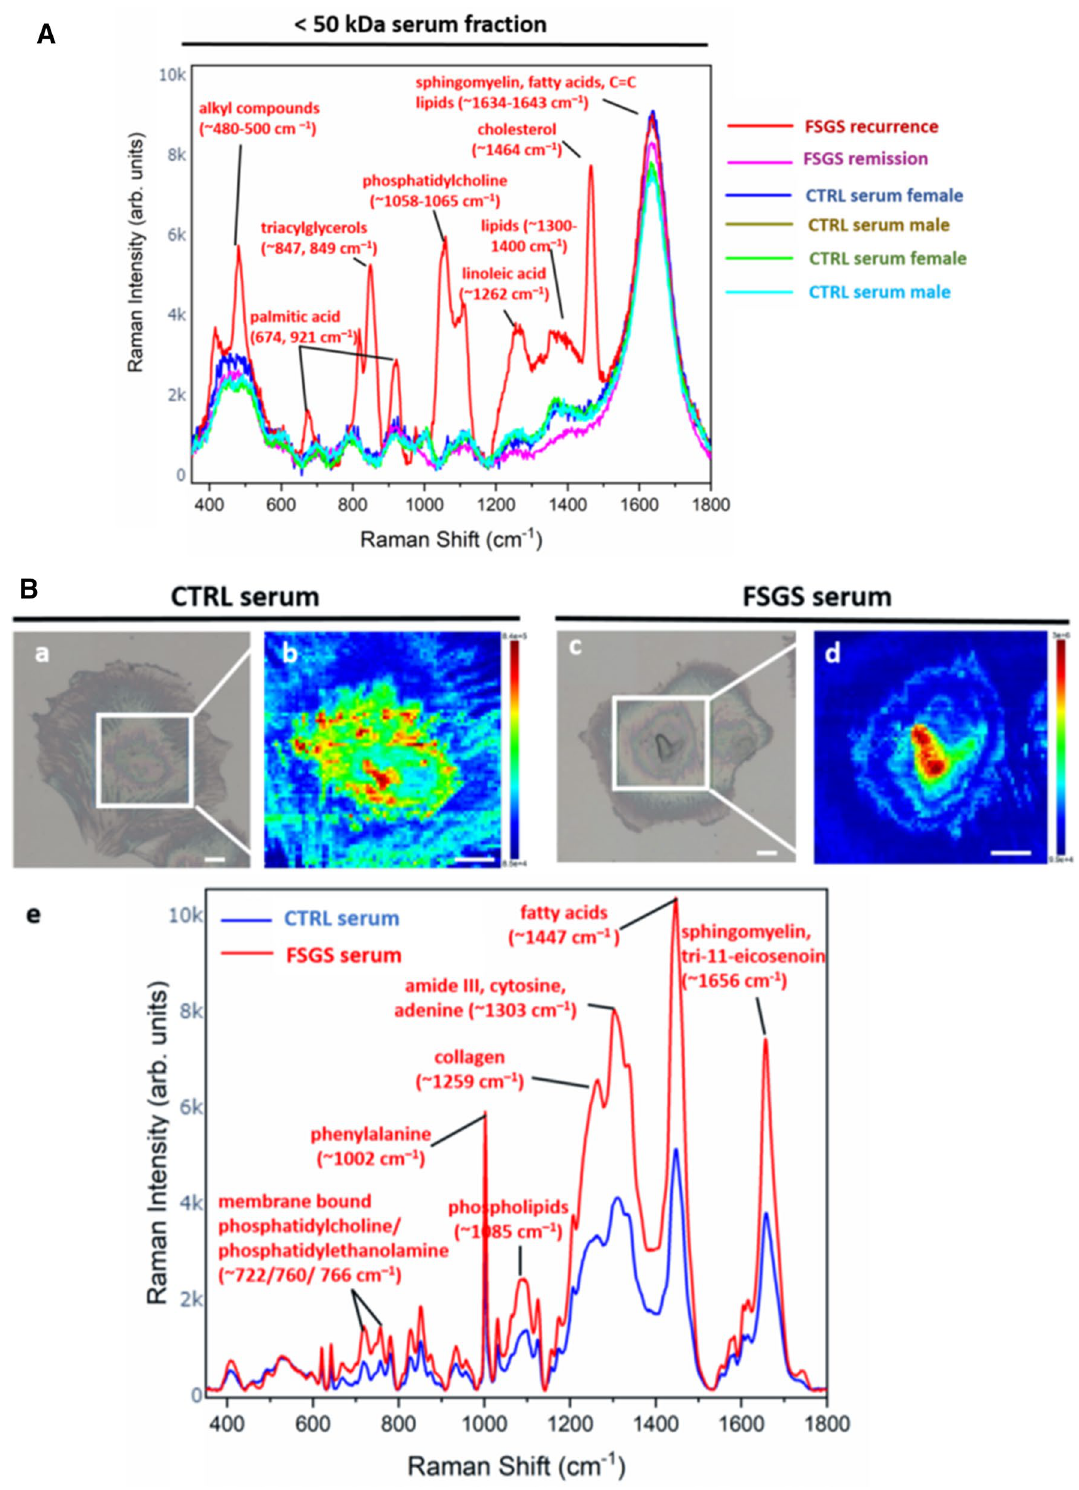
Figure 3. Raman spectroscopy reveals molecular fingerprint of FSGS serum and changes in podocyte metabolome induced by FSGS serum. ( A ) Mean Raman spectra of < 50 kDa serum fractions of FSGS at the time of disease recurrence (red), at the time of remission (purple) as well as of < 50 kDa serum fractions of four healthy control person (dark blue, green, brown and light blue). Different Raman signal corresponding mostly to lipoproteins were detected at the time of FSGS recurrence. Raman signals at the time of FSGS remission however resembled Raman signals of the CTRL serum fraction. Assignments of the Raman peaks according to the literature are given. ( B ) Representative bright field illumination (a,c) and heat map of Raman signal intensity (b,d) of cultured human podocytes treated with CTRL serum (a,b) and FSGS serum (c,d). Scale bar 10 µm. (e) Mean Raman spectra of three podocytes treated with FSGS serum (red line) and three podocytes treated with CTRL serum (blue line) showing increased Raman signal for FSGS treated